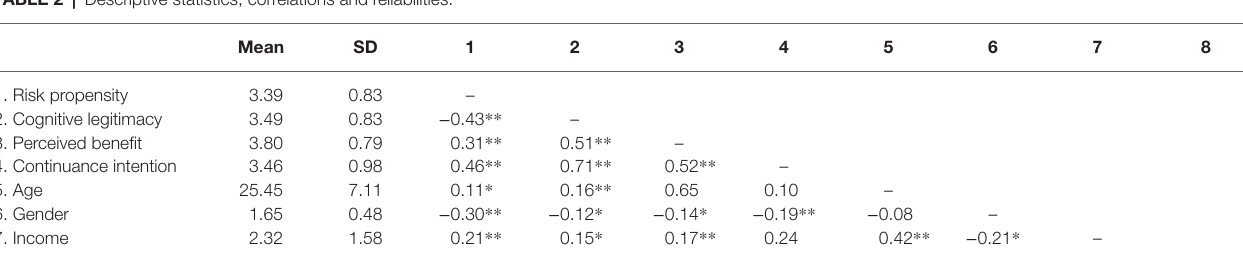
TABLE 2 | Descriptive statistics, correlations and